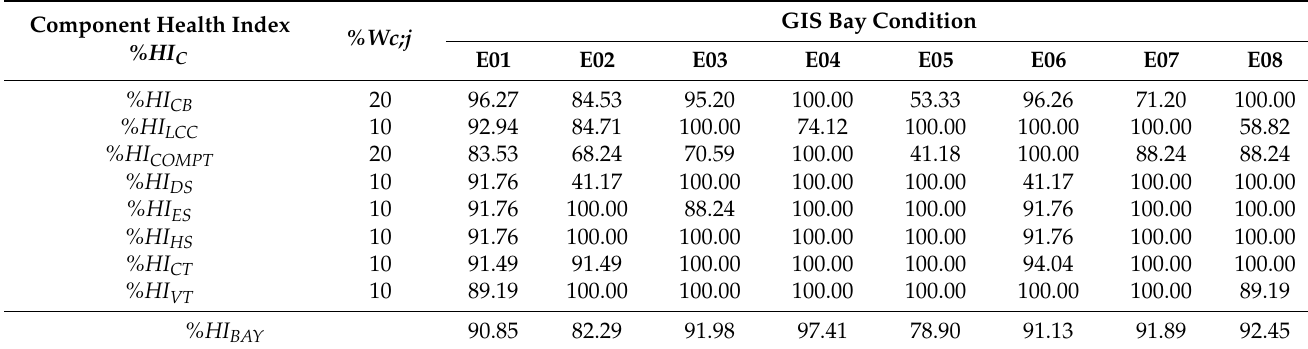
Table 11. Example of bay health index evaluation of substation.